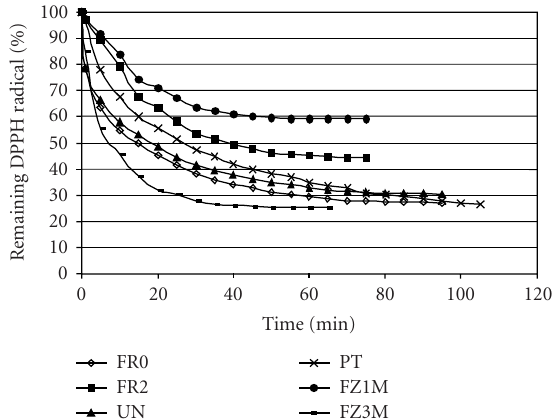
Figure 2. Kinetic behaviour of reducing DPPH radical of an- thocyanins found in blueberry extract after the following treat- ments: FR0 : fresh blueberries; FR2: fresh blueberries kept at 5 ◦ C for two weeks; UN : untreated blueberries dried in a cabinet dryer; PT : osmotically pretreated blueberries dried in a cabinet dryer; FZ1M : frozen blueberries kept at − 20 ◦ C for 1 month; FZ3M : frozen blueberries kept at − 20 ◦ C for 3